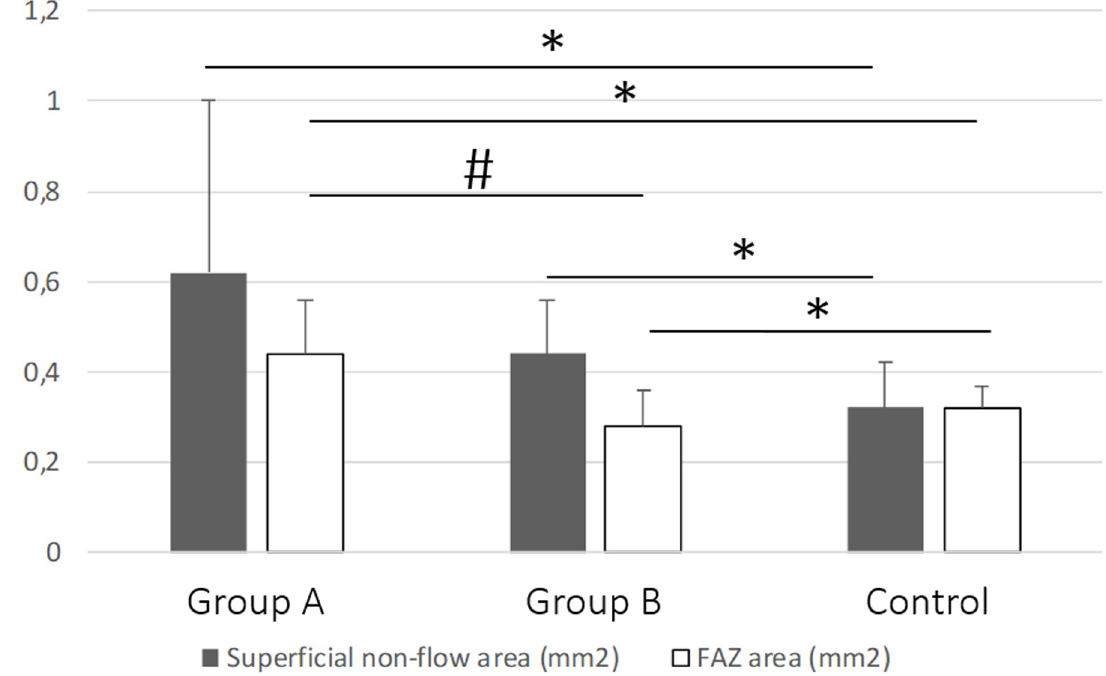
Fig 4. Diagram of the mean and SD of superficial non-flow area and FAZ. � p < 0.05 from the control group, †p < 0.05 between Group A and